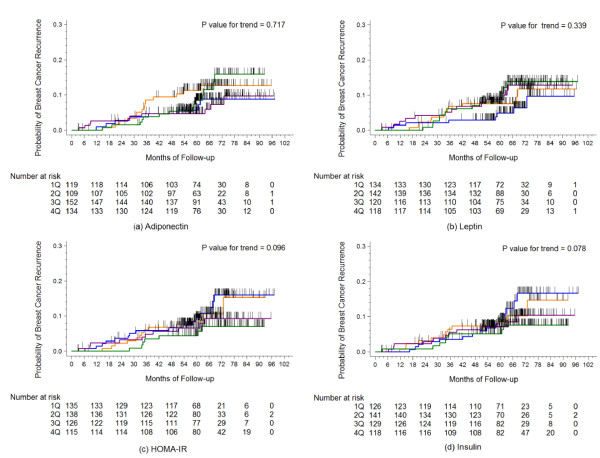
Kaplan-Meier cumulative recurrence curves for breast cancer patients in the estrogen receptor/progesterone receptor positive group. The P-values for trend were calculated using the log-rank test for trend across the quartiles of adiponectin, leptin, HOMA-IR, and insulin. The hatch marks on the curves indicate times when patients were censored.